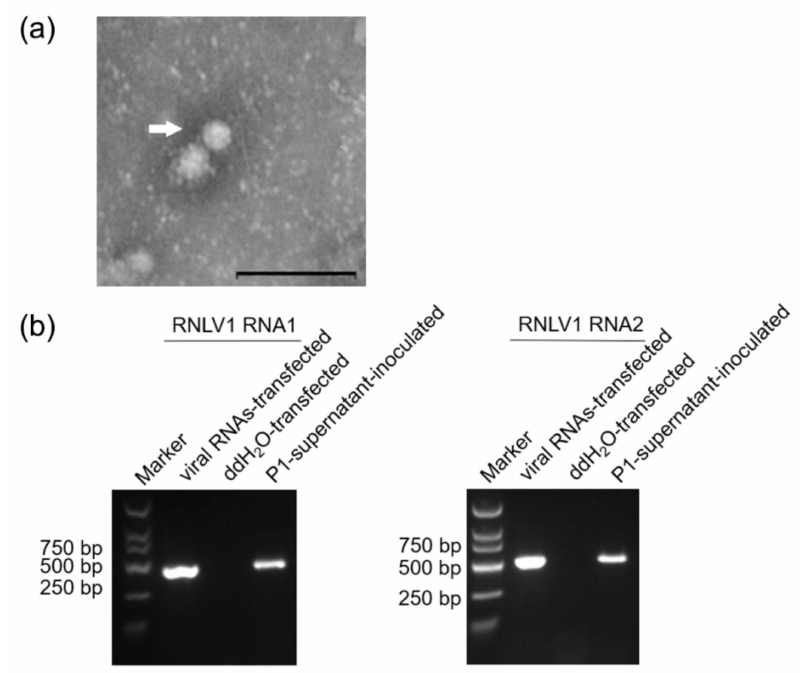
Figure 6. RNLV1 can replicate in insect Sf9 cells. ( a ) An electron micrograph showing negatively stained RNLV1 virions from the transfected Sf9 cells. Bars = 200 nm. ( b ) RT-PCR analysis of RNLV1 replication in Sf9 cells. Sf9 cells were transfected with in vitro transcribed RNLV1 RNA transcripts, double distilled water (ddH 2 O, the negative control), or inoculated with the P1-supernatant from the transfected Sf9 cells. After three days, these cells were analyzed for RNLV1 infection through RT-PCR using primers specific for the negative strand RNA1 (422 bp, left panel) or RNA2 (509 bp, right